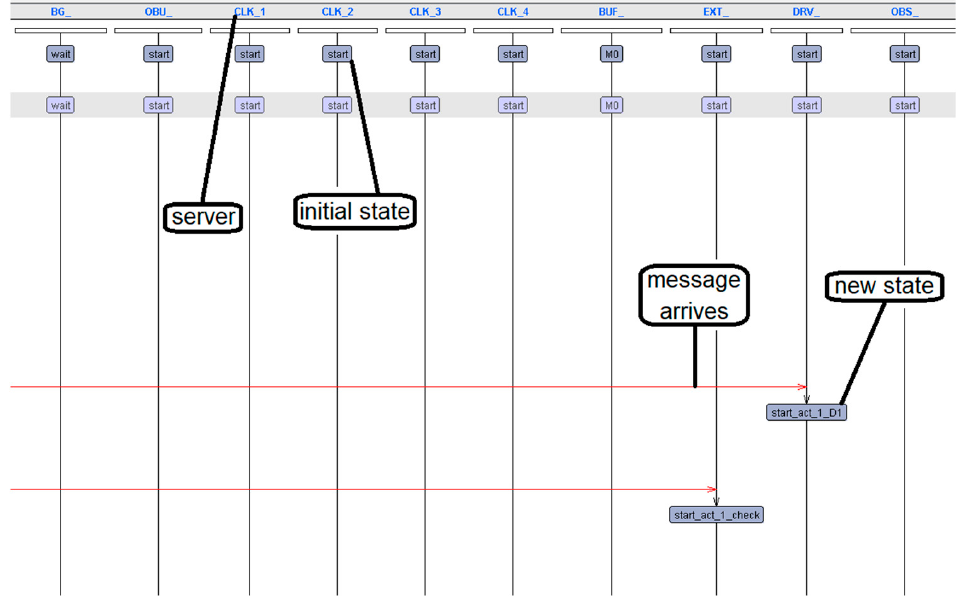
Figure 15. The beginning part of the counterexample, as shown by the Uppaal verifier. The balloons point to specific elements of the counterexample.